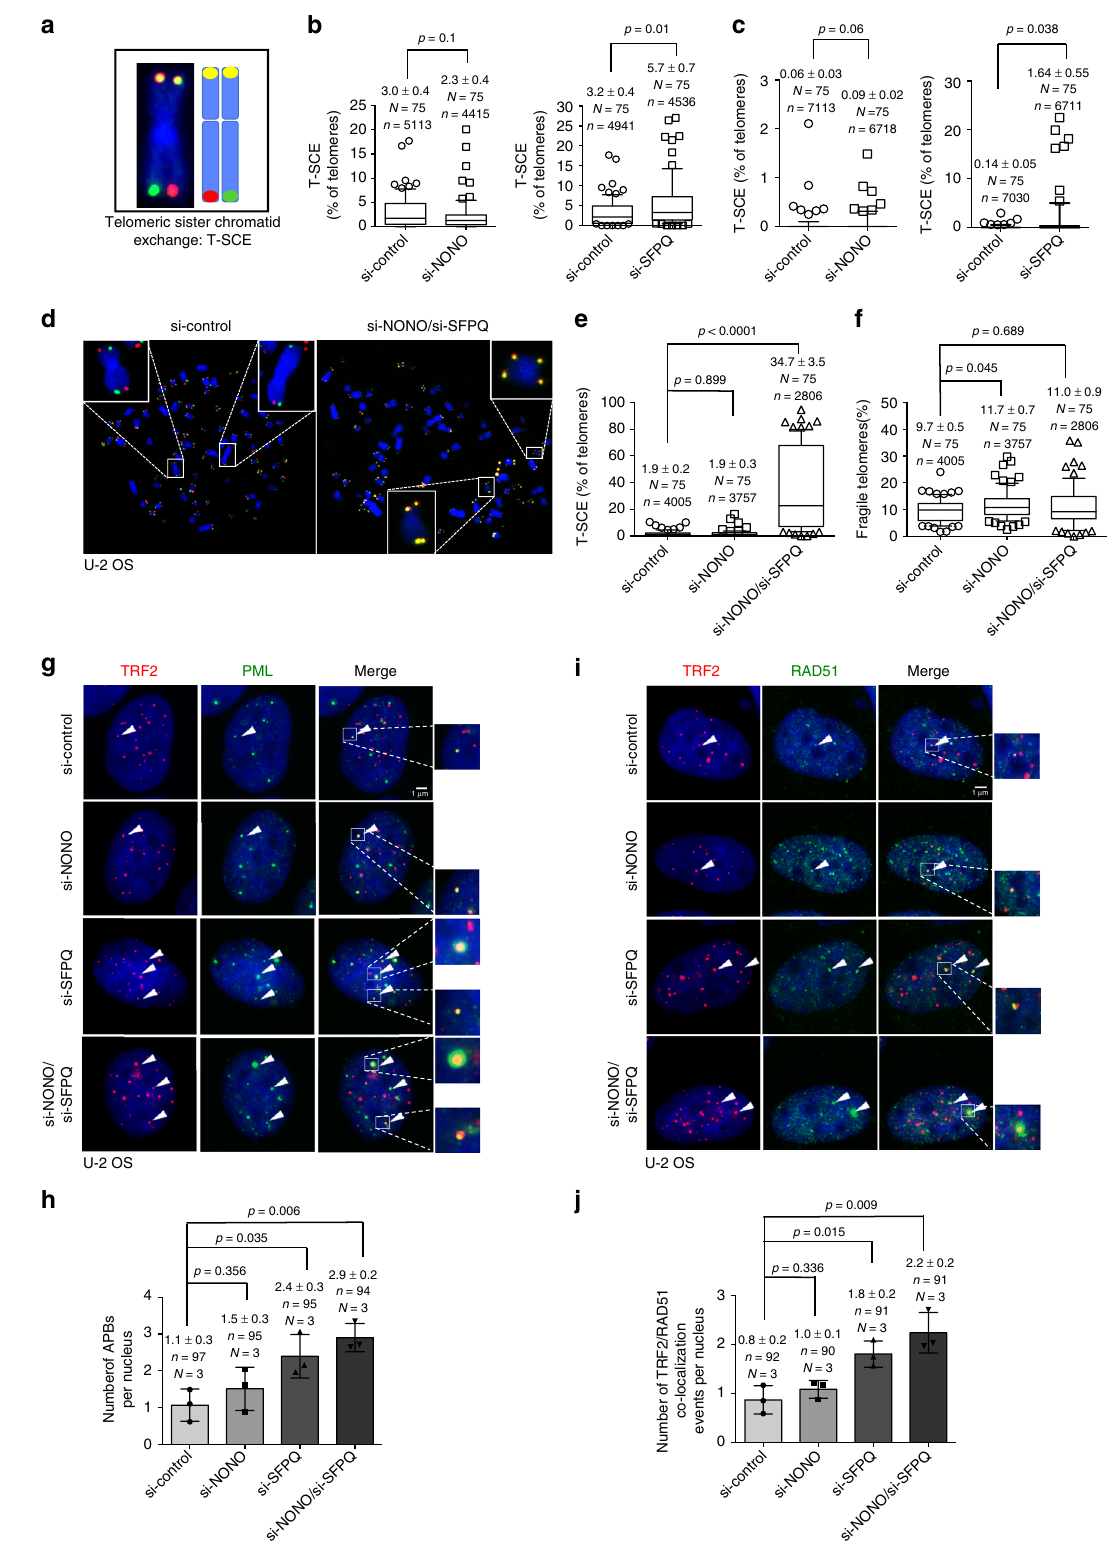
(Fig. 6e, f). This effect was found to be enhanced in SFPQ- depleted and 5-Aza-2 ′ -deoxycytidine-treated H1299 cells, sug- gesting the activation of a functionally relevant subnuclear compartment for the ALT pathway (Fig. 6e, f). Importantly,